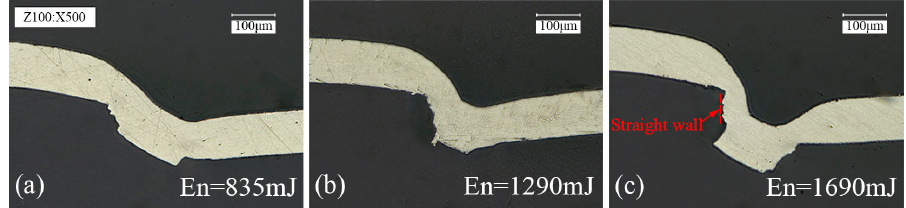
Figure 4. Cross sections of single layer 1060 pure aluminum foil (100 μ m in thickness) produced under different laser energy En ( h = 70 μ m, 1 pulse): ( a ) En = 835 mJ; ( b ) En = 1290 mJ; ( c ) En = 1690 mJ. different laser energy En ( h = 70 µ m, 1 pulse): ( a ) En = 835 mJ; ( b ) En = 1290 mJ; ( c ) En = 1690